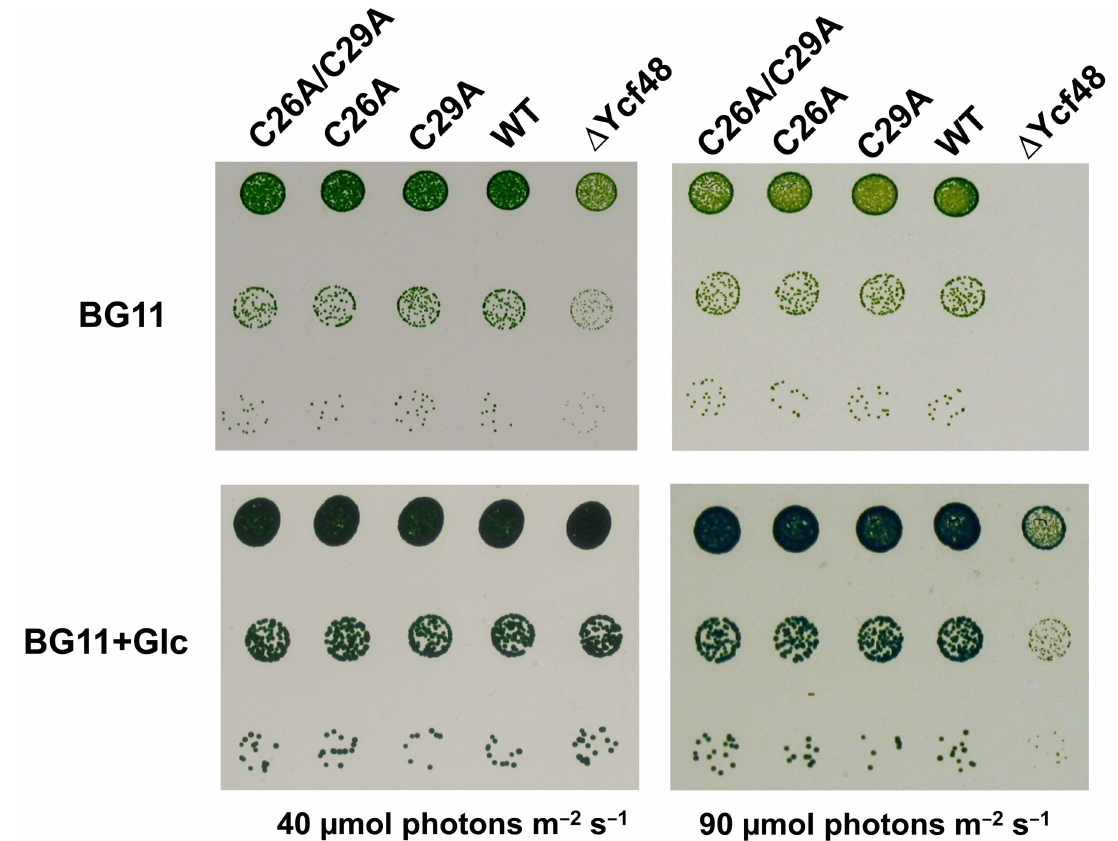
Figure 4. Growth of wild type (WT), C mutants, and Ycf48-less mutant on agar plates under autotrophic (BG11) and photoheterotrophic (BG11+Glc) (40 µ mol photons m − 2 s − 1 ) conditions at growth (40 µ mol photons m − 2 s − 1 ) and increased (90 µ mol photons m − 2 s − 1 ) irradiance. The growth assay was performed as described in